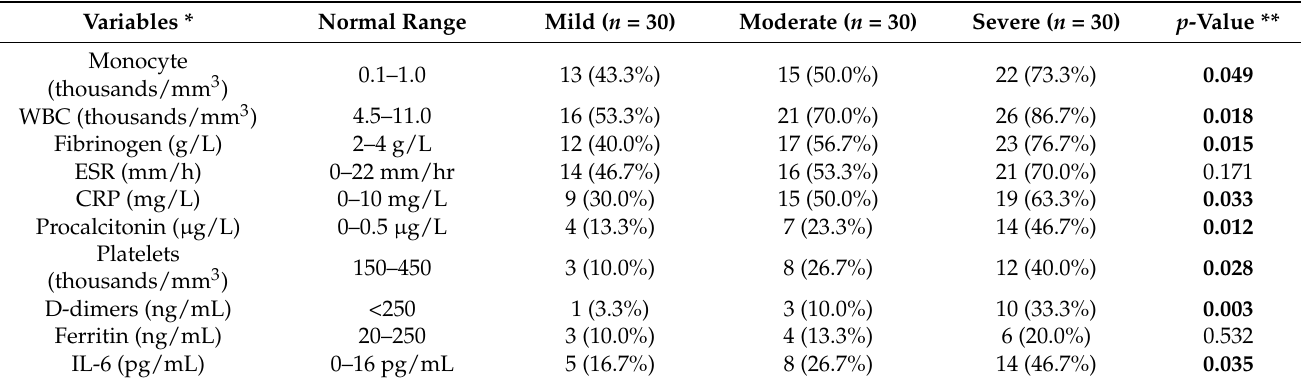
Table 3. Laboratory profile of study participants by the severity of COVID-19.